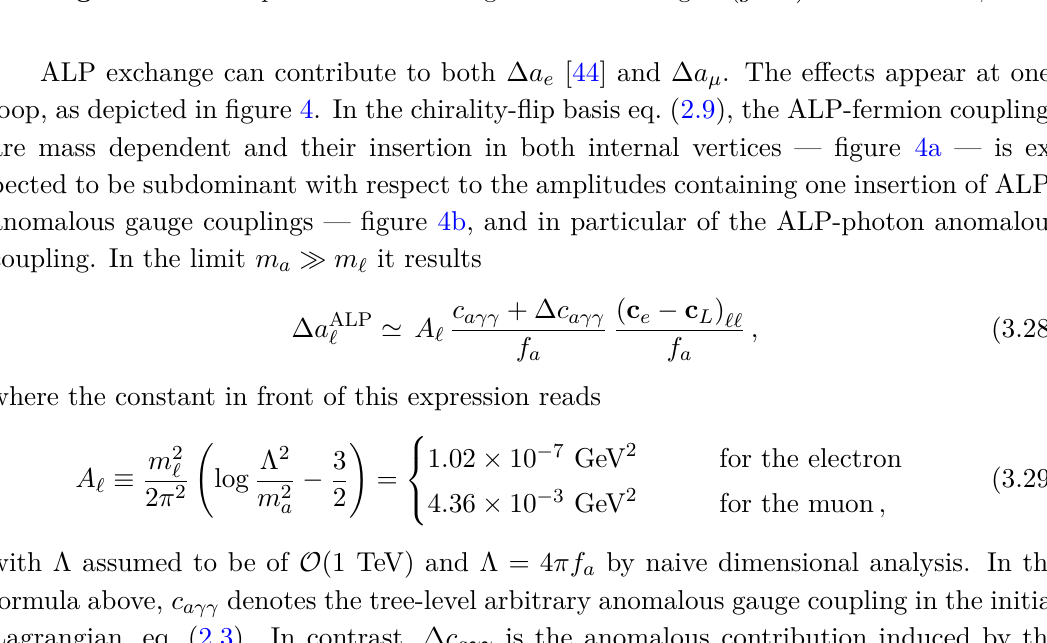
Figure 4. One-loop ALP-mediated diagrams contributing to ( g − 2) of the fermion ψ .